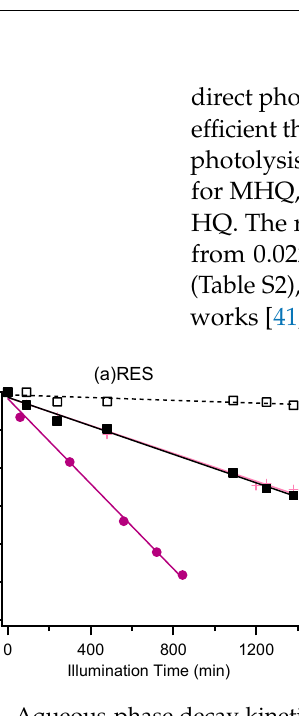
Figure 1. Aqueous-phase decay kinetic curves for ( a ) resorcinol (RES), ( b ) hydroquinone (HQ), and ( c ) methoxyhydroquinone (MHQ).